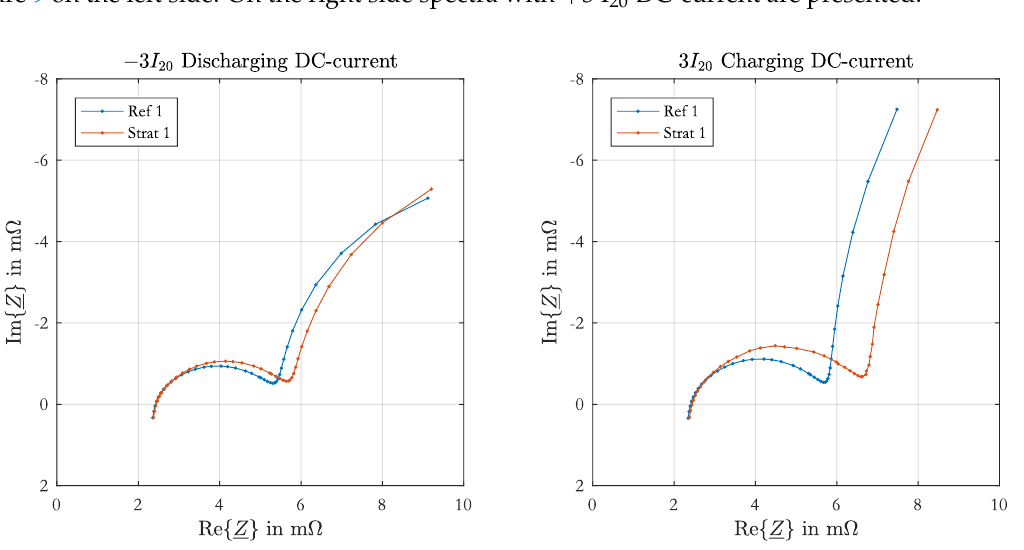
Figure 9. Simulated impedance spectra of the srEEC with ± 3 I 20 for I cell . The blue spectra corresponds to simulations with homogeneous electrolyte and the red spectra to simulations with stratified electrolyte as during Strat. 1